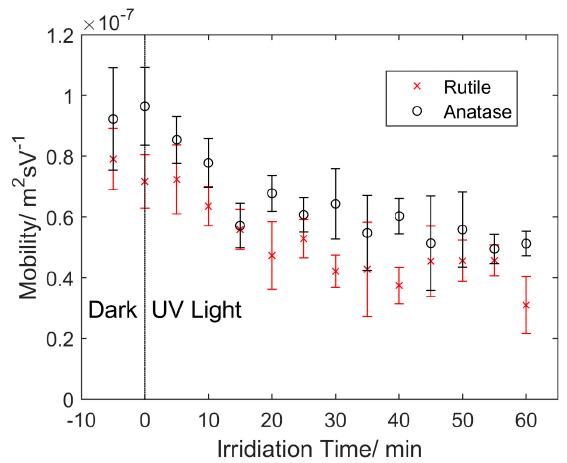
Figure 3. Measured particle mobility of the rutile and anatase submicron particles over time. The UV light was turned on at 0 h. The electric field strength was 0.99 V/mm.